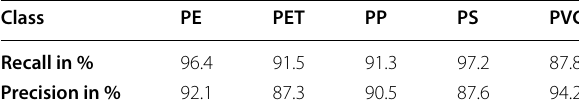
Table 3 Precision and recall of deep learning (one single